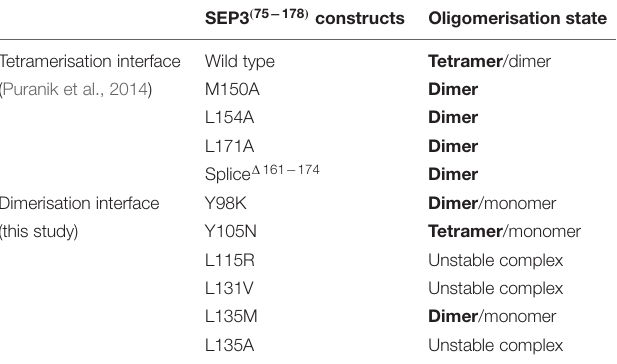
TABLE 2 | Effect of point mutations on SEP3